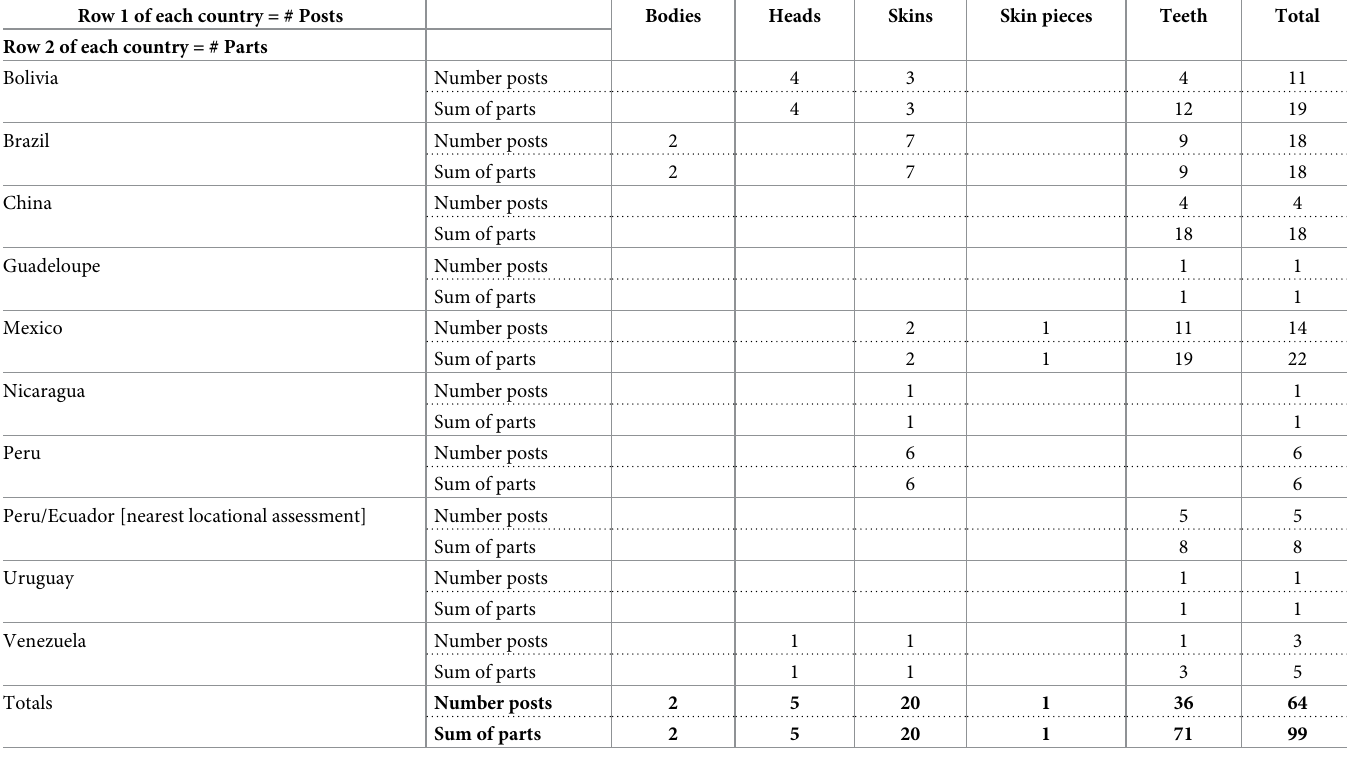
Table 2. Visually confirmed jaguar body parts by country or region (# posts per country or region of posting; sum of parts by country or region of posting). Row 1 of each country = # Posts Bodies Heads Skins Skin pieces Teeth Total Row 2 of each country = #